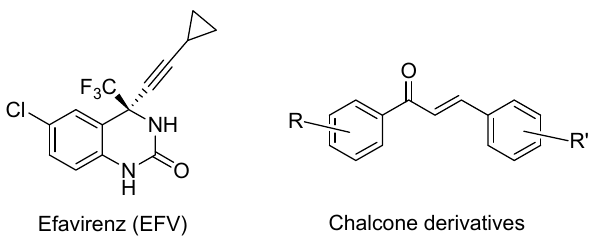
Figure 1. Example of molecules synthesized via propargylic alcohol